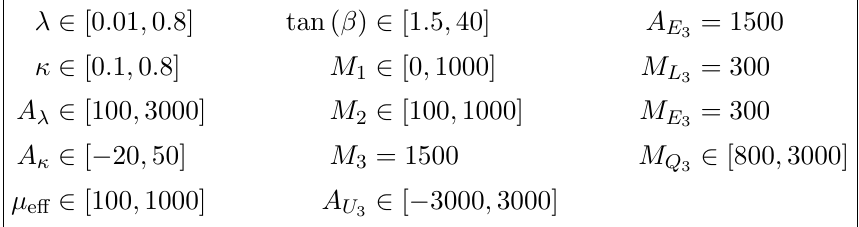
Table 1 . Range of parameters and masses used for numerical scan. Energy units are in GeV.